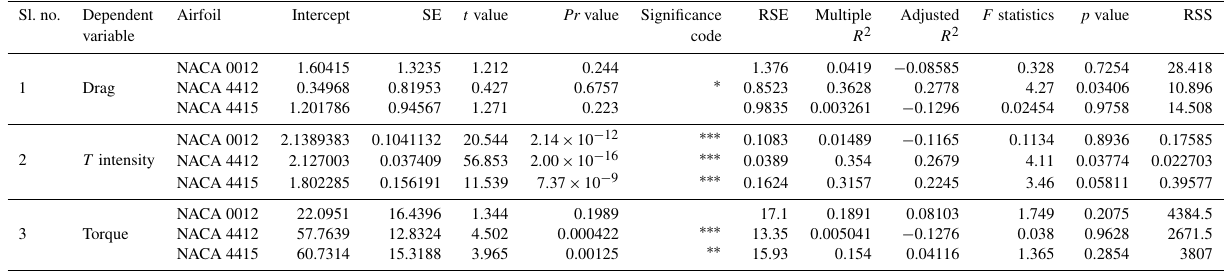
Table 7. Data generated from the R program for drag, turbulence intensity, and torque. RSS denotes the residual sum of squares; RSE denotes the relative standard error. Sl. no. is the serial number. The significance codes are shown as follows: ∗ 0.01, ∗∗ 0.001, ∗∗∗ 0. Sl. no. Dependent